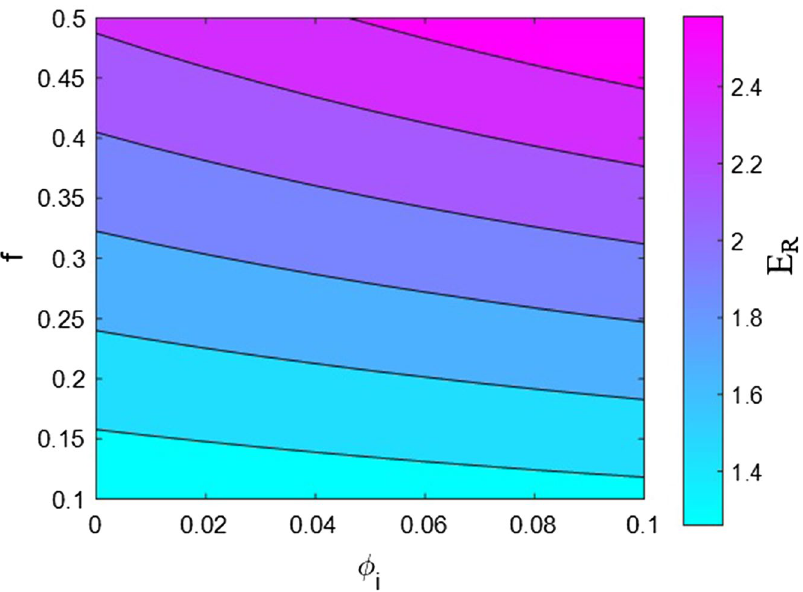
Figure 8. Effects of interphase content and proportion of networked HNTs/interphase section on the “E R ” according to the proposed